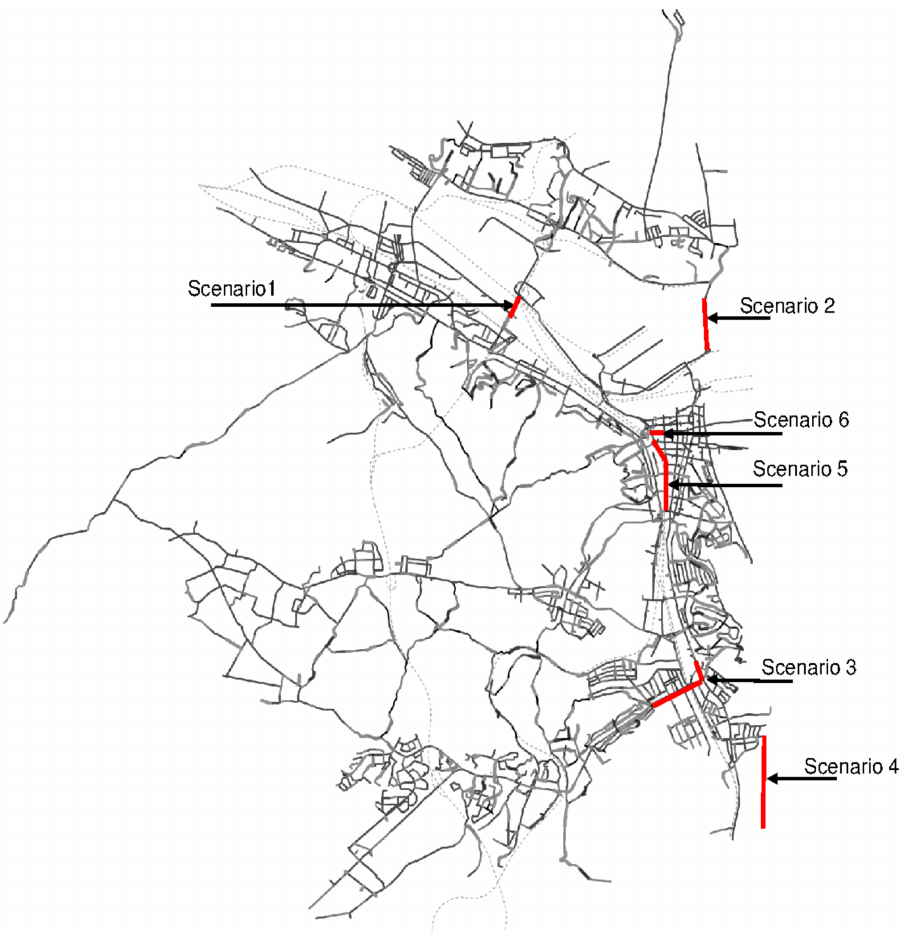
Figure 6. Scenarios for the development of the Gdynia urban cycling